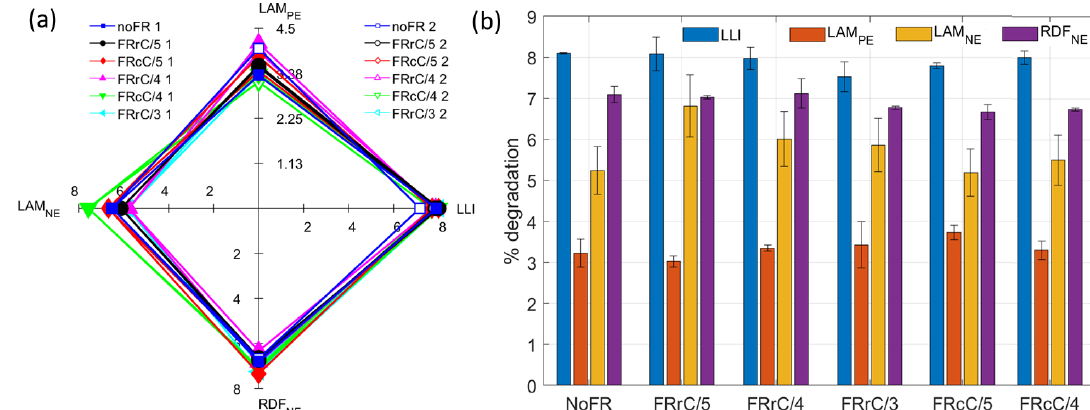
Figure 5. ( a ) Spider plots of the four prominent degradation modes for all the cells at 3000 Ah (~8% capacity loss) and ( b ) bar plot showcasing the impact of the duty cycles. The error bar represents the spread between the two tested cells for each duty cycle, not a distribution of values. LLI: loss of lithium inventory, LAM: loss of active material on the positive (PE) and negative (NE) electrodes, and RDF NE : rate degradation factor on the NE.